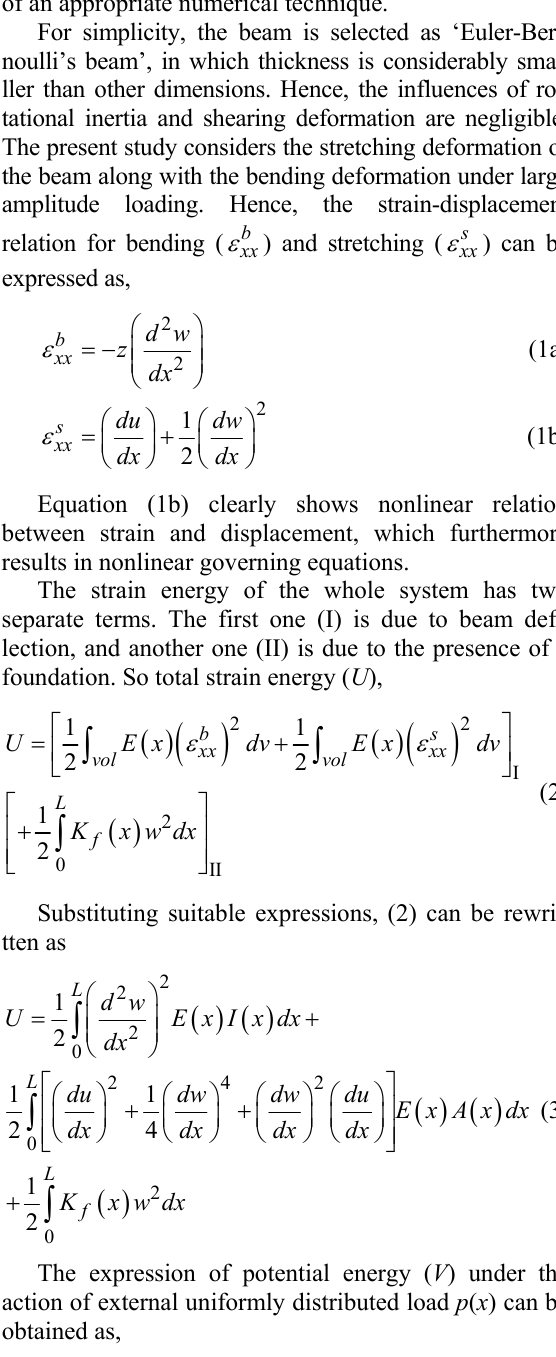
Table 1. List of start functions for bending ( w ( ξ )) and stretching ( u ( ξ )) displacement field.